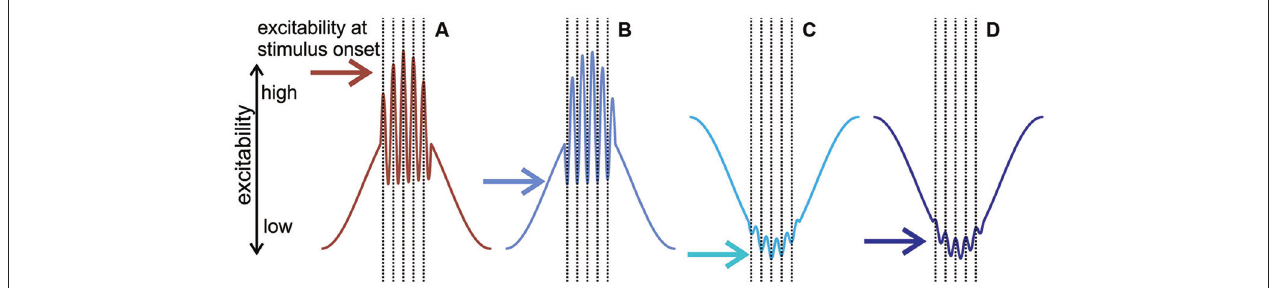
FIGURE 8 | The predicted effect of delta—gamma phase amplitude coupling and multiscale entrainment to various phases on neuronal excitability. (A) Diagram of neuronal excitability when delta and gamma are both entrained to their depolarizing phases: depolarizing delta results in large amplitude gamma, and as gamma is also at its depolarizing phase at the time of the stimuli, this results in a high excitability state when stimuli are expected to occur. (B) Depolarizing delta/hyperpolarizing gamma: the amplitude of gamma is still large but as it is entrained to its hyperpolarizing phase, this results in a relatively low neuronal excitability state at the onset of stimuli, which should lead to transient MUA response suppression. In (C,D) delta is entrained to its hyperpolarizing phase and therefore gamma amplitudes are small, thus gamma phase (hyperpolarizing in (C) and depolarizing in (D) does not play a major role in neuronal excitability modulation). Therefore, we predict sustained MUA suppression due to the hyperpolarizing phase of delta in both